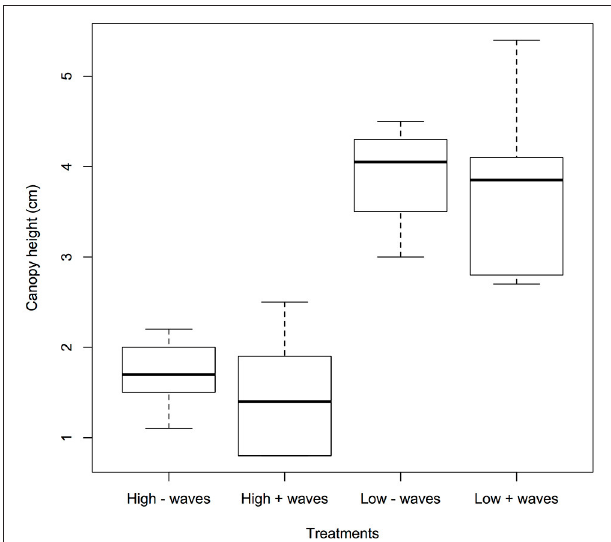
FIGURE 2 | Showing seagrass canopy height (cm) under different treatments: high (0.3m s − 1 ) and low (0.05m s − 1 ) currents without/with waves. To obtain each replicate for canopy height, the position and motion of 10 plant leaves were traced onto paper through the transparent flume wall. A significant difference was seen for the two velocities ( p < 0.05) and with and without waves ( p <